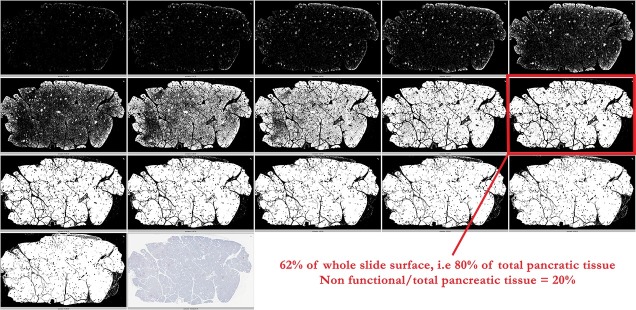
Example on the slide 14262.The second R script, used for the selection of the pixels belonging to functional pancreatic tissue, generated 16 different propositions. The choice of the investigator is framed in red and the subsequent results indicated under the picture.